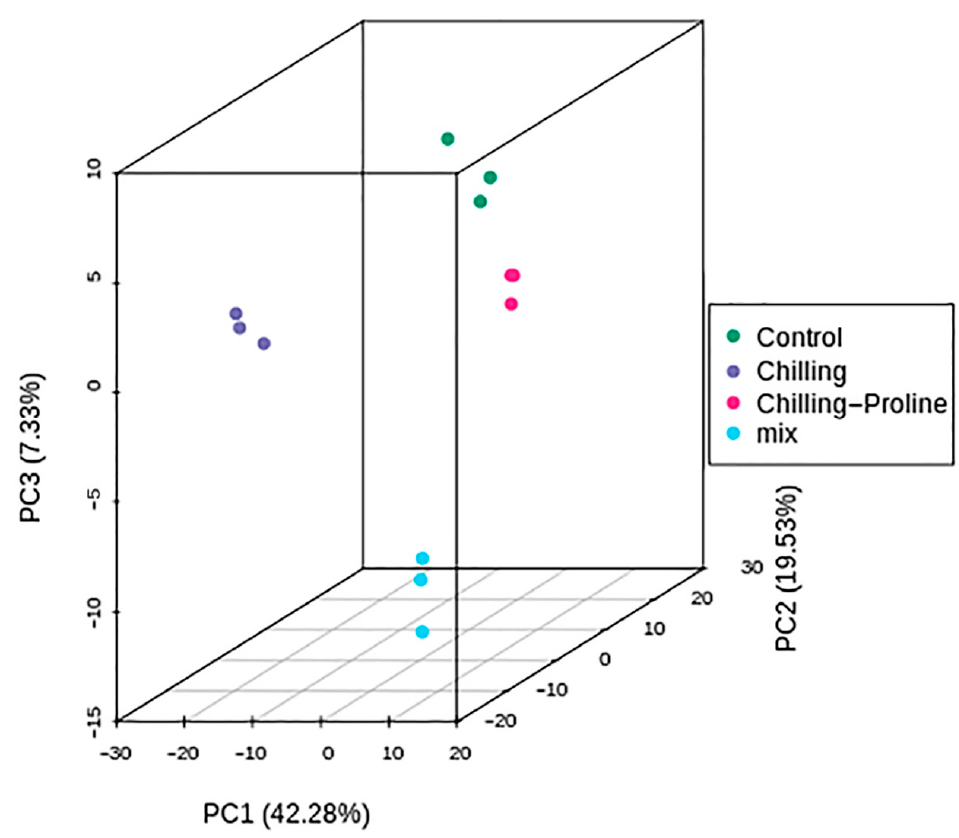
Figure 9. PCA score map of all samples.